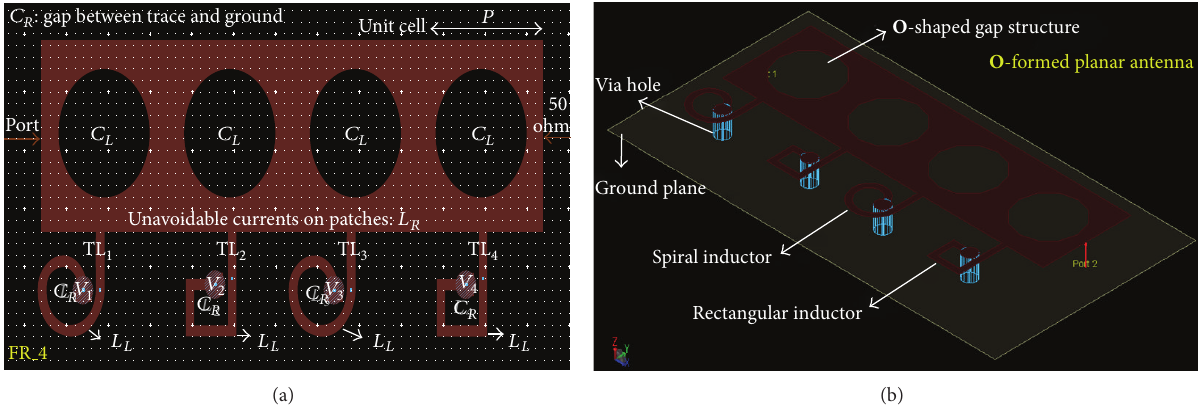
Figure 4: Layout of four unit cell of the proposed O -shaped antenna structure: (a) top view, (b) isometric view.